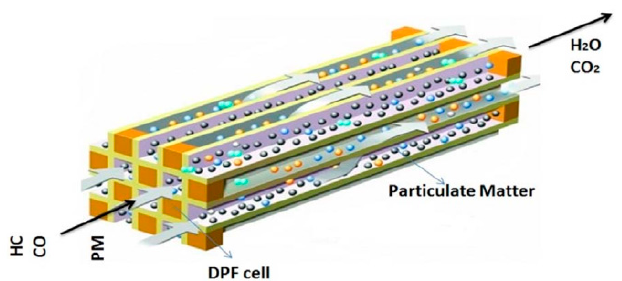
Figure 1. Principle of DPF for trapping particulate matters. Reprinted from Reference [24], with the permission from Elsevier.